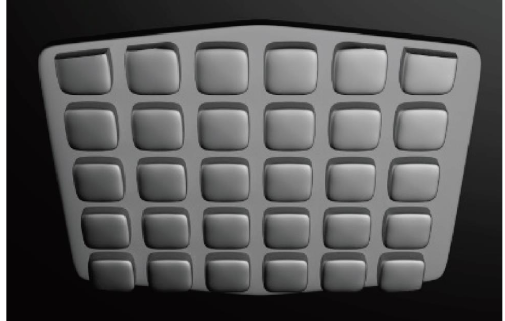
Figure 8: Pad lock